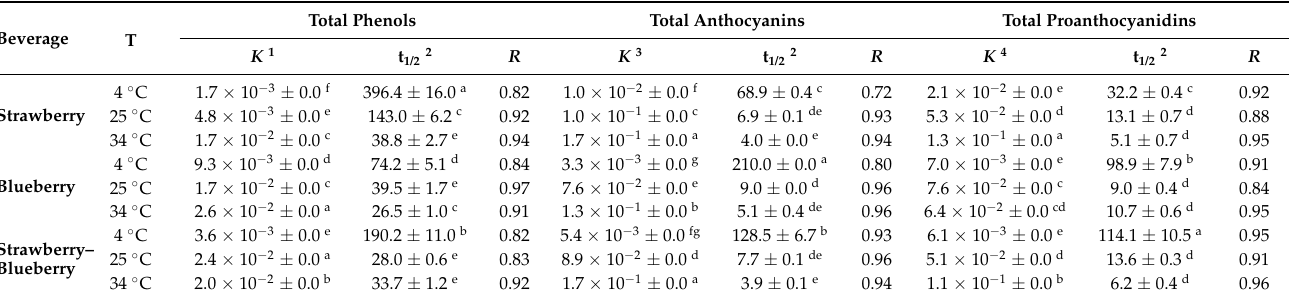
Table 3. First-order reaction kinetics for total phenolic compounds, total monomeric anthocyanins, and total proanthocyanidins stability of the berry-based beverages stored at 4 ◦ C for 90 days and 25 ◦ C and 34 ◦ C for 12